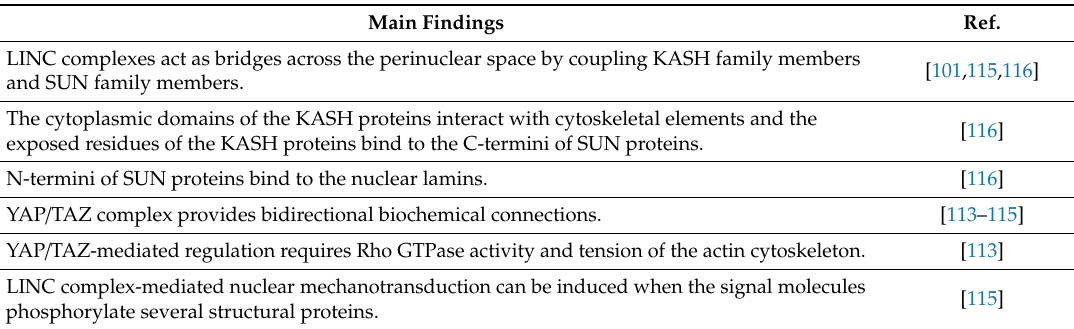
Table 8. Sensing information transfer between the cell surface and nucleus. Main Findings